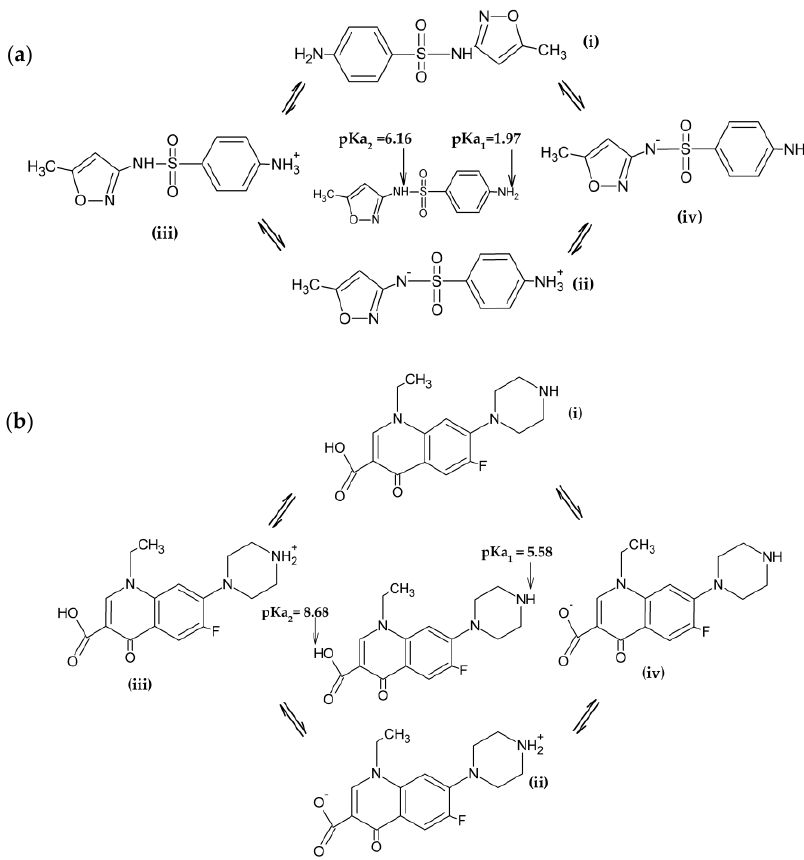
Figure 2. The different protonated states of SMX ( a ) and NOR ( b ) depending on pH: (i) neutral, (ii) zwitterionic, (iii) cationic, and (iv) anionic.